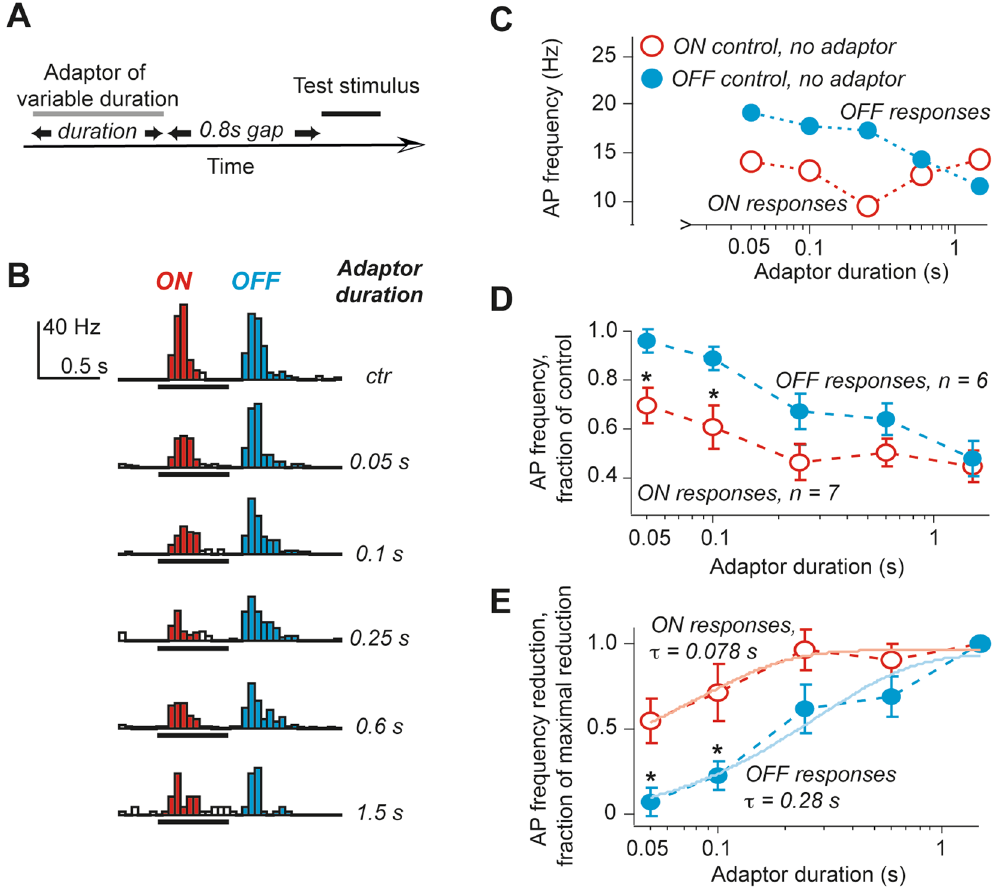
Figure 3. Even a very brief presentation of an adaptor was sufficient to induce long lasting adaptation. ( A ) A schematic representation of stimulation paradigm. ( B ) An example PSTH of responses obtained with adaptors of different duration. Note a clear decrease in the ON response bar amplitude, depicted in red, following a 0.05 s adaptor stimulus. OFF responses (blue PSTH bars) were unchanged following a 0.05 s adaptor. ( C ) The average normalized response amplitudes are plotted as a function of the adaptor stimulus duration. In the left upper corner ON and OFF response amplitude values without adaption are shown. ( D ) The summary of all tested units. ( E ) The same data as in D re-plotted as a function of the maximal decrease in the AP rate during responses. Lines represent fits to a mono-exponential function. In ( D , E ) asterisks indicate statistically significant differences between ON and OFF responses (p <